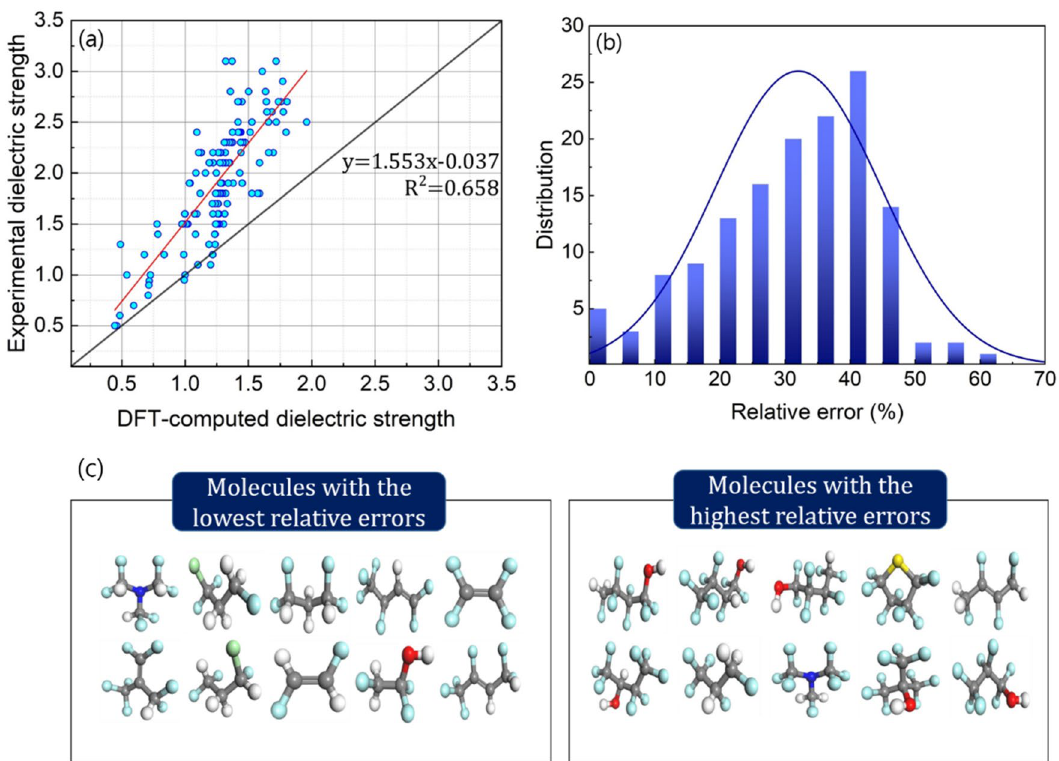
Figure 5. Validation of original computational protocol for dielectric strength. ( a ) Comparisons between the equation-predicted and measured values for the dielectric strength (relative to SF 6 = 1.0). ( b ) Errors of the equation-predicted dielectric strengths relative to their experimental values. (c) Structures of organic compounds with the lowest and highest relative errors.